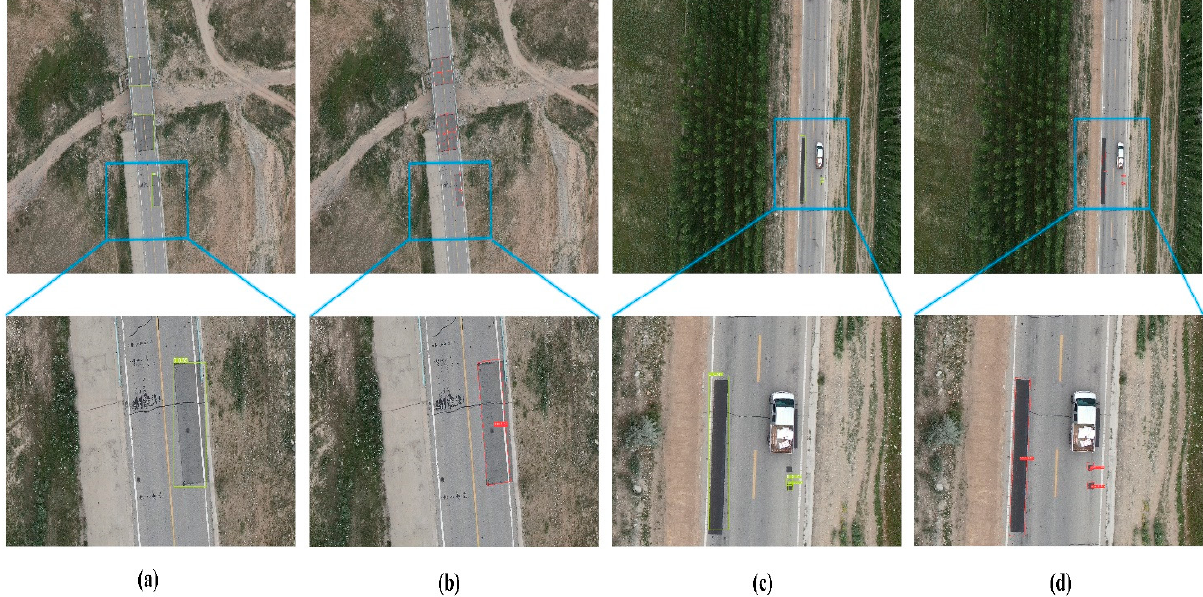
Figure 12. Comparison graph of algorithms for the different conditions of flight altitude. ( a , c ) Mo- bileNetv3 + YOLOv5s + CSL test results. ( b , d ) MR-YOLO test results.